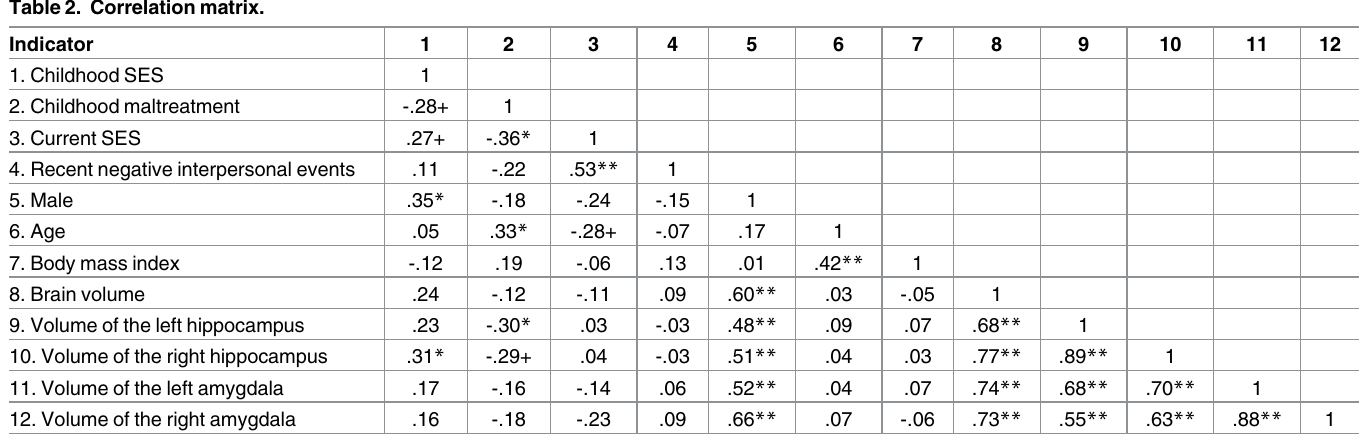
Correlation matrix presenting correlations for childhood and current SES, childhoodmaltreatment, recent negative interpersonal events, regional brain volumes, and covariates